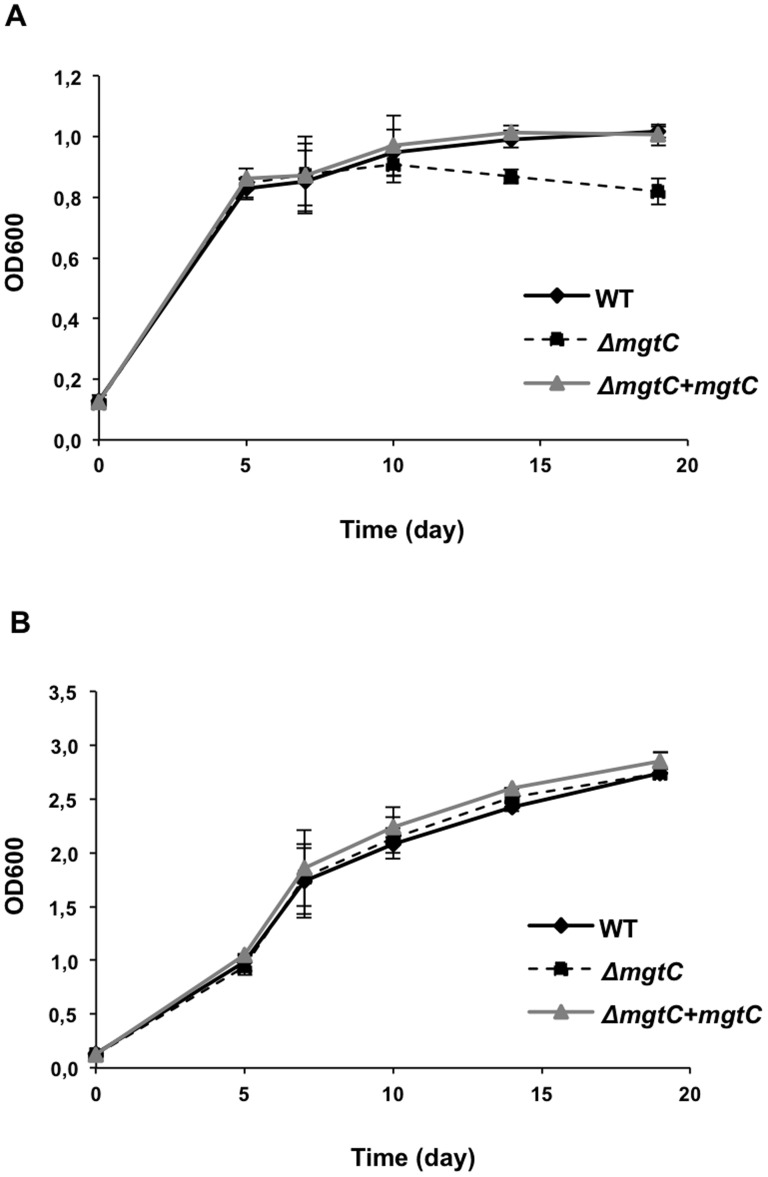
Growth of Mma mgtC mutant in Mg2+ deprived liquid medium.(A) Growth curves of M. marinum wild-type, ΔmgtC and ΔmgtC+mgtC::attB strains grown in Sauton's medium without magnesium. (B) or in regular Sauton's medium supplemented with magnesium. OD600 is indicated over the growth period. The curves from two independent experiments are shown with SD.